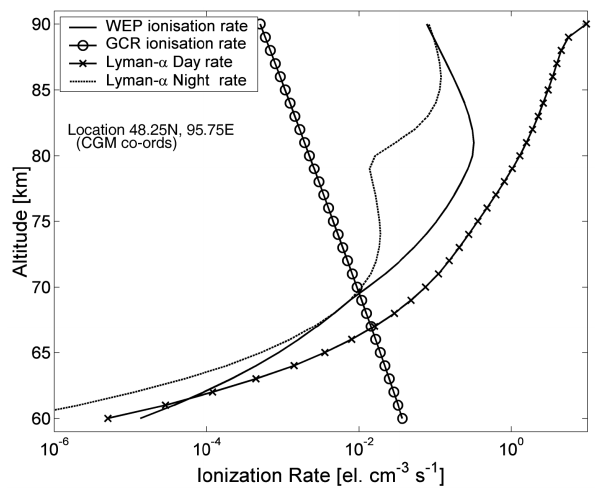
Fig. 4. Contrast between ionisation rates due to differing drivers at the location marked in Fig. 1 (in Poland). The solid line shows the ionisation rate profile with altitude produced by WEP, to be con- trasted with that produced by GCR (circles), and midday and mid- night photoionisation (crosses and dotted,